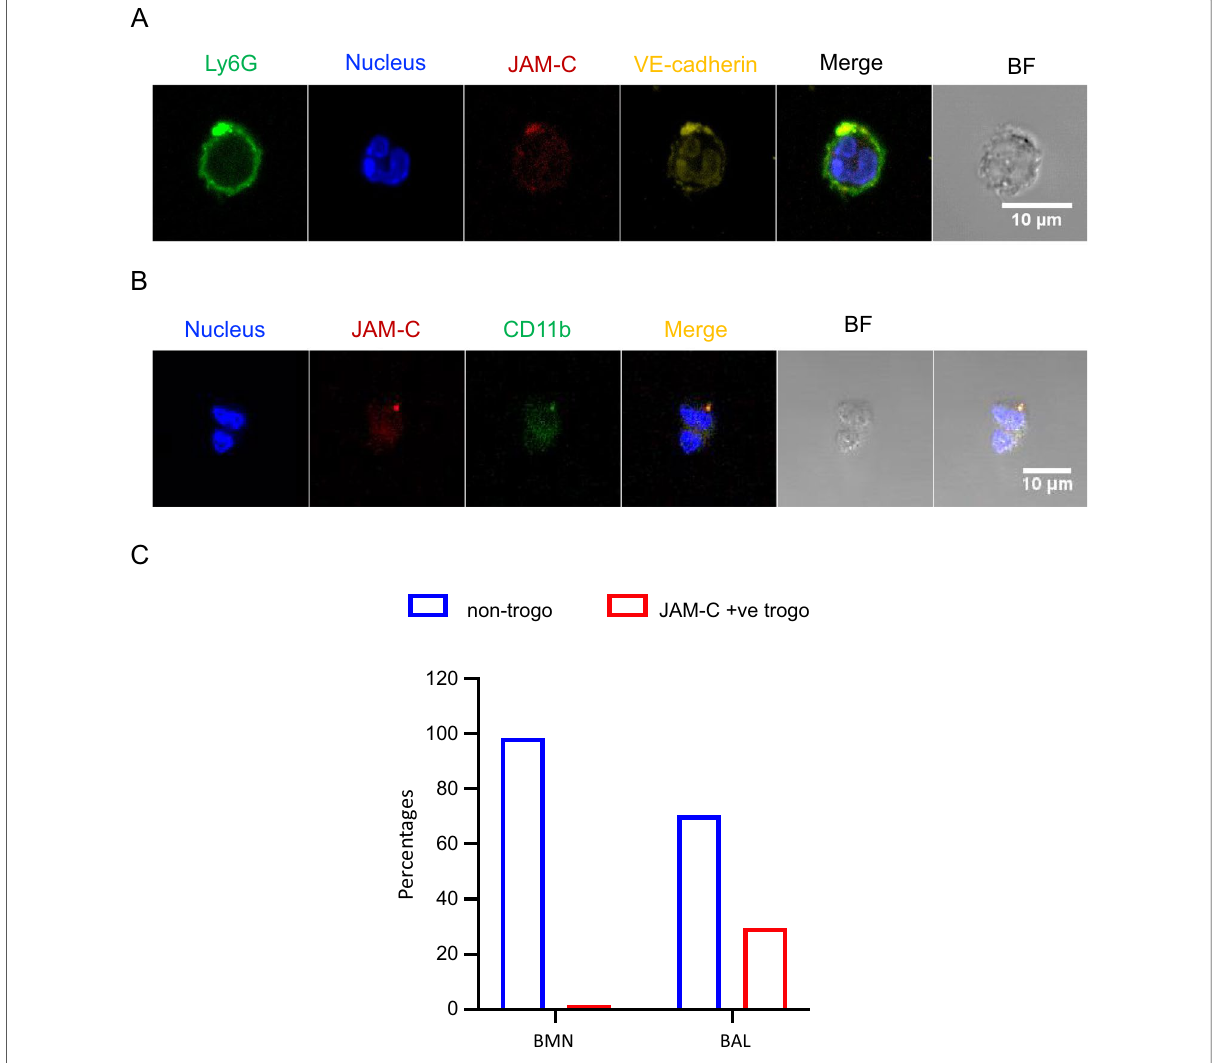
Fig. 6 Trogocytosis of neutrophils is observed in injured Lung. The acute lung injury model was used to detect the trogocytosis of neutrophils. The mice were challenged with LPS by direct intra-tracheal instillation. The neutrophils from mouse lungs were collected by bronchoalveolar lavage (BAL). A To show the trogocytosis of neutrophils in mouse lung tissue, the purified neutrophils from BAL fluid were subjected to antibody staining with anti-Ly6G, anti-JAM-C, and anti-VE-cadherin antibody. The nucleus of the cells was stained with Hoechst33342. Scale bar, 10 µm. B The neutrophils were also subjected to immunofluorescence staining with anti-JAM-C antibody and anti-CD11b antibody to show co-localization of the two markers in the neutrophils. Scale bar, 10 µm. C The trogocytosis of purified neutrophils were quantified by observing the cells (over 500 cells each for BMN and BAL neutrophils) with confocal microscopy. The number of trogocytosis was determined by observing JAM-C positive ( puncta on the edge of cells. Data are shown in